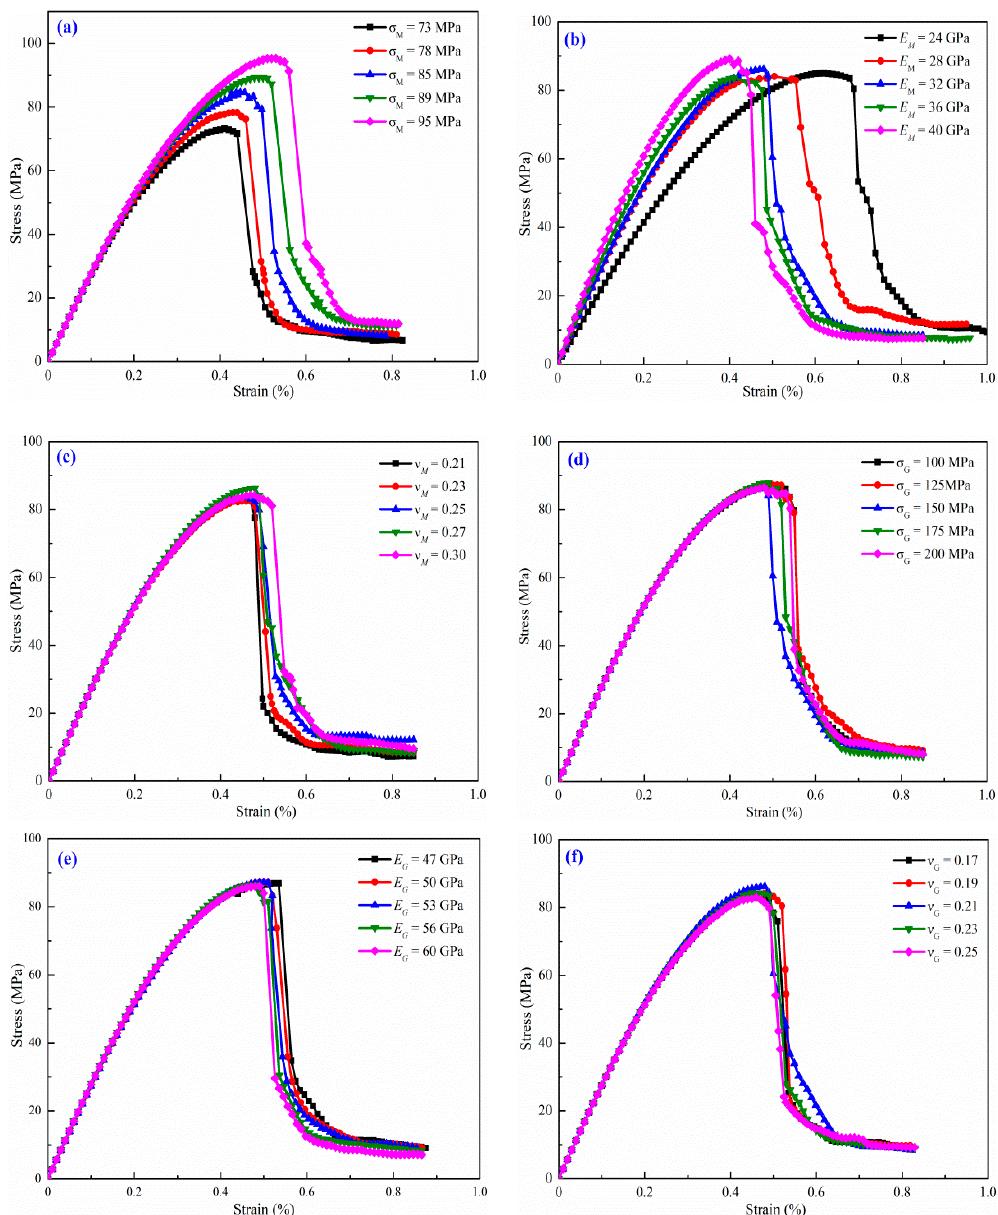
Figure 18. Stress–strain response of glutenite with variation of individual mechanical parameters. Graphs ( a – c ) correspond to σ M , E M , and ν M of the matrix and ( d – f ) correspond to σ G , E G , and ν G of the gravel.